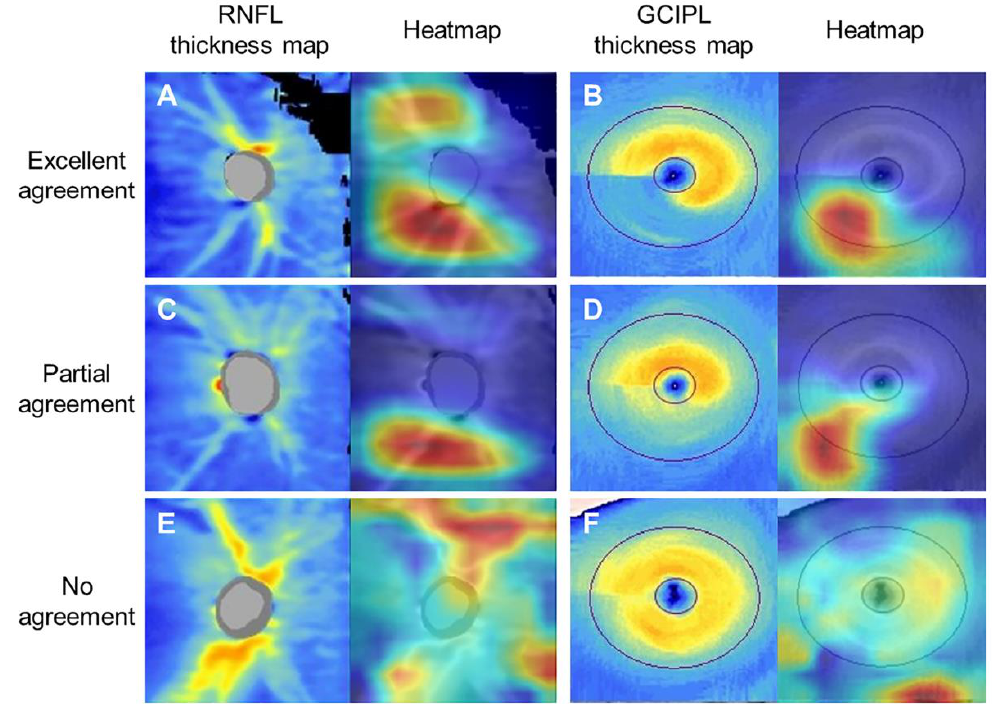
Figure 3. Heatmaps highlighting the region of high probability for glaucoma diagnosis were generated to validate the deep learning system using retinal nerve fiber layer (RNFL) and ganglion cell–inner plexiform layer (GCIPL) thickness maps of spectral-domain optical coherence tomography. Images are representative RNFL and GCIPL thickness maps and corresponding heatmaps for which the deep learning system produce predictions resulting in ( A , B ) excellent, ( C , D ) partial, and ( E , F ) no agreement with glaucoma specialists on RNFL and GCIPL defect locations. A. Glaucoma specialists confirmed superotemporal and inferotemporal RNFL defect from the RNFL thickness map; the heatmap showed that the deep learning system detected the same lesion, showing high agreement between them. B. Glaucoma specialists and the heatmap agreed on an inferotemporal GCIPL defect. C. Superotemporal and inferotemporal RNFL defects were confirmed by glaucoma specialists, but only the inferotemporal lesion was demonstrated on the heatmap, thus showing partial agreement. D. A whole inferior GCIPL defect was confirmed by a glaucoma specialist, but only part of the lesion was shown on the heatmap. E. Discrepancy between the colored lesion on the heatmap and the thin, superotemporal RNFL defect detected by glaucoma specialists, showing no agreement. F. A thin, inferotemporal GCIPL defect was confirmed by glaucoma specialists, but the heatmap showed an irrelevant lesion.